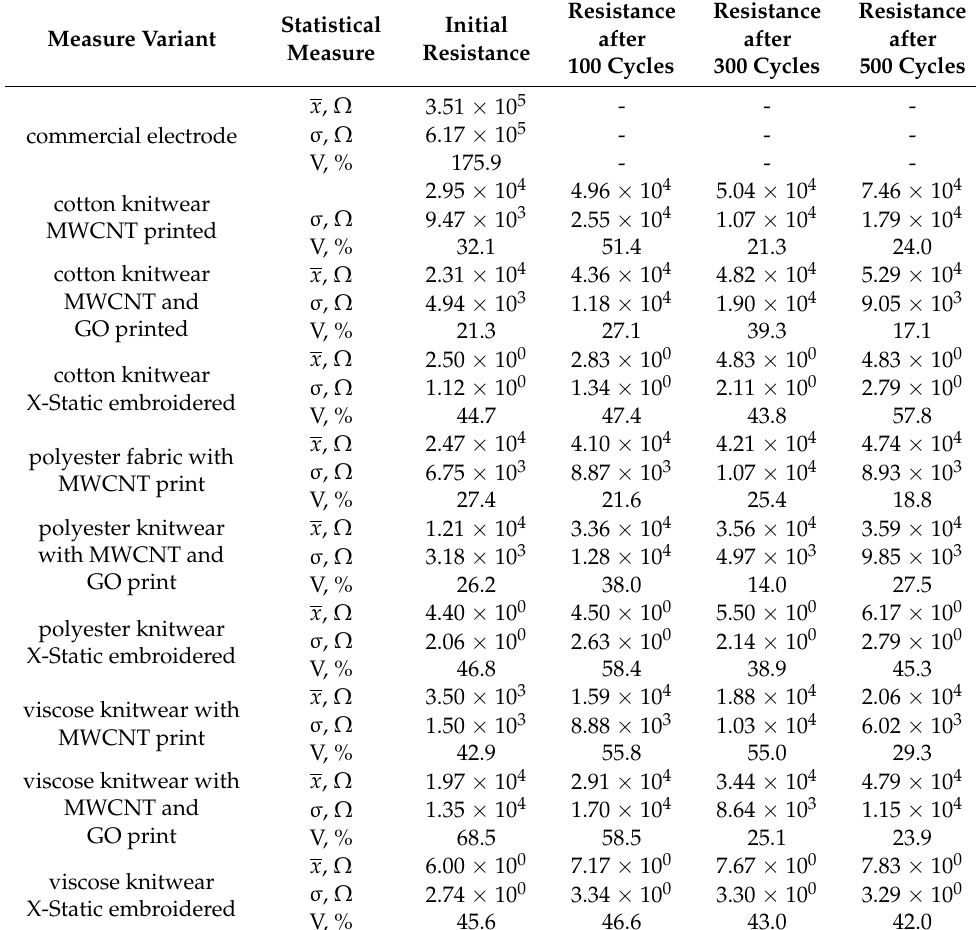
Table 6. Results of average values of surface resistances in test materials after the tensile process.